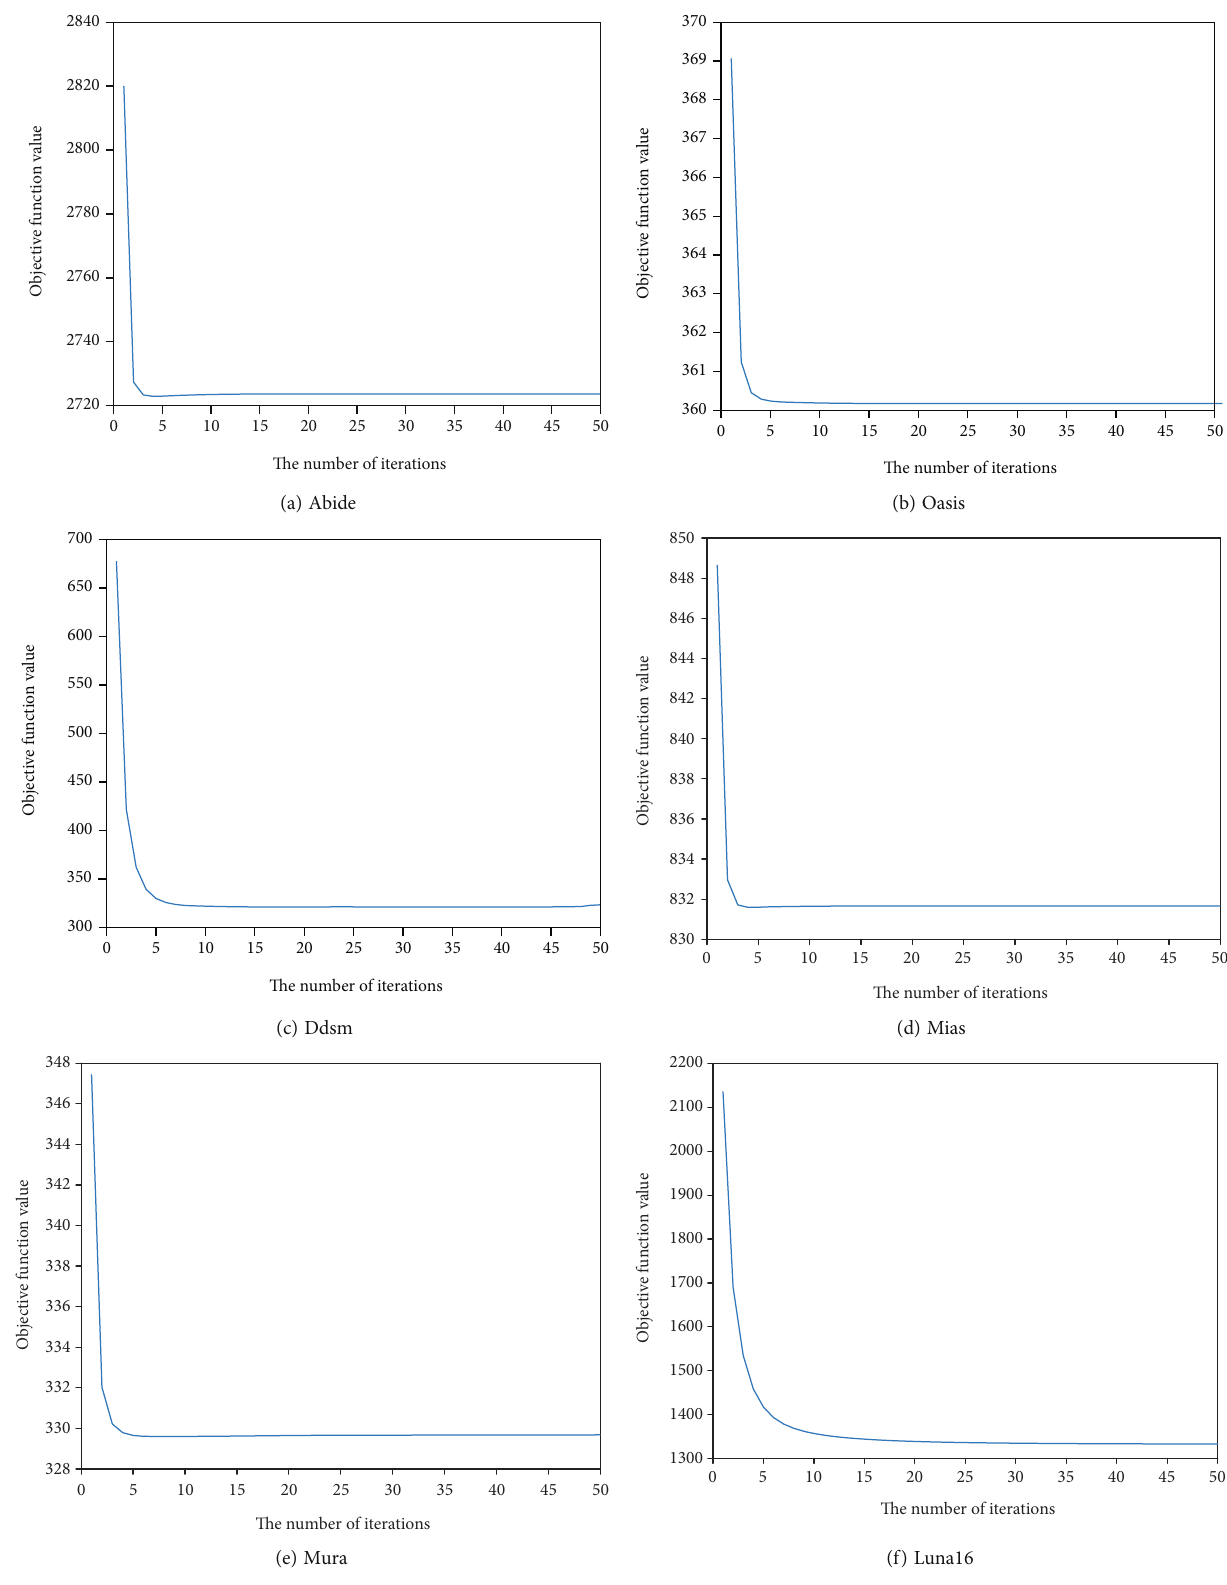
Figure 8: Convergence of the suggested algorithm on experimental